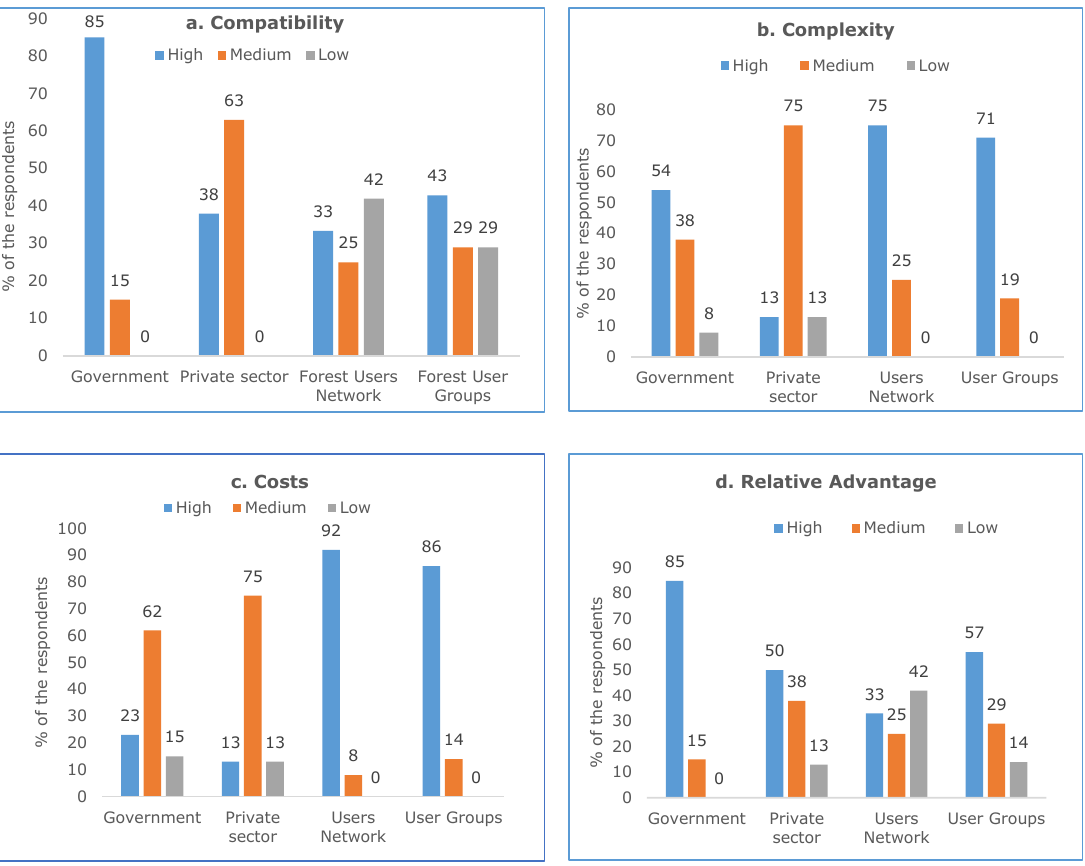
Figure 2. Stakeholder’s perspectives on SciFM based on the key attributes ( n = 40) ( a ) compatibility of SciFM, ( b ) complexity of SciFM, ( c ) costs of SciFM adoption and ( d ) relative advantage of